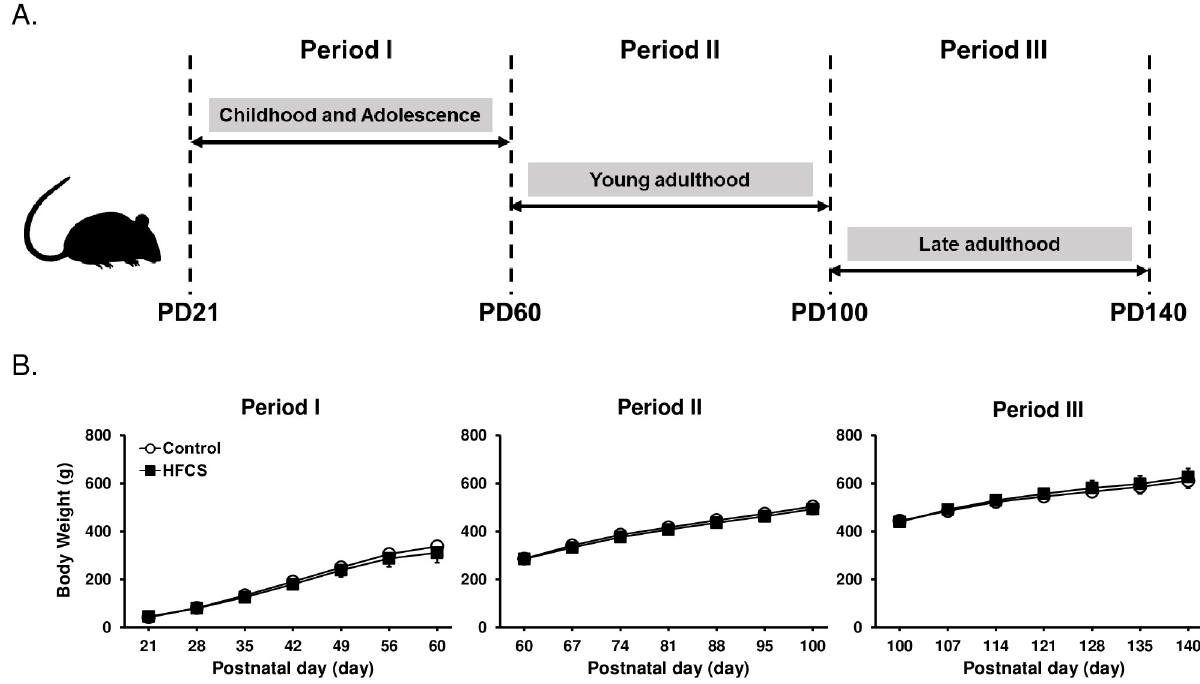
Fig 1. Body weight during each experimental period. (A) Experimental schedule of this study. (B) No significant differences were observed in the body weight between the two groups. Period I: C and H, n = 7, Period II: C and H, n = 8, Period III: C and H, n = 7. C, Control group; H, HFCS group. Data are presented as the mean ±